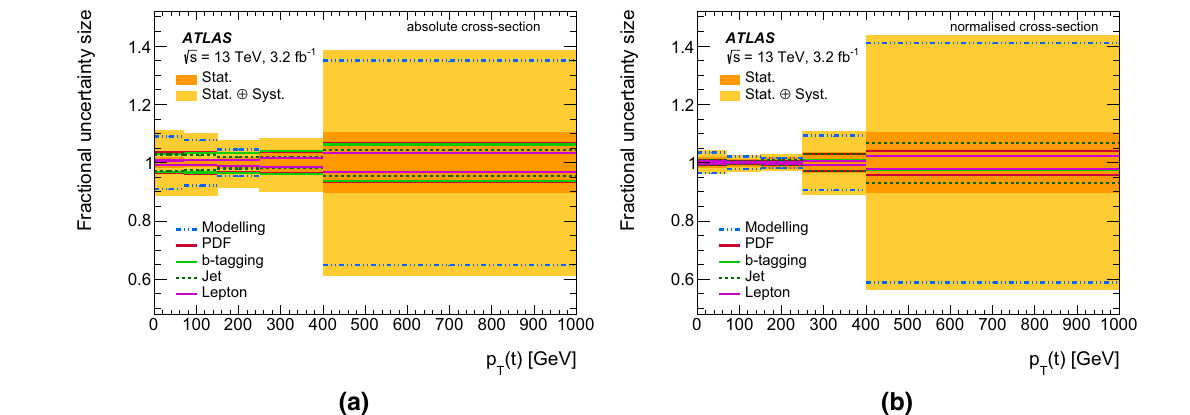
Fig. 4 Summary of the fractional size of the absolute ( a ) and nor- malised ( b ) fiducial differential cross-sections as a function of p T ( t ) . Systematic uncertainties which are symmetric are represented by solid lines and asymmetric uncertainties are represented by dashed or dot –